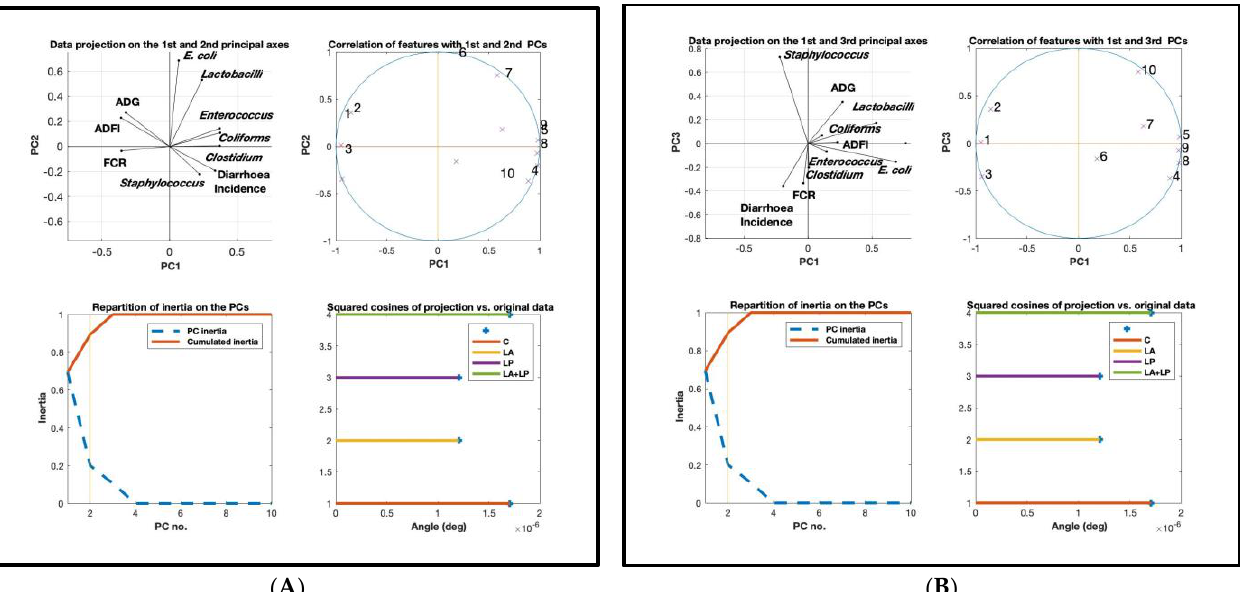
Figure 4. Results of the principal component analysis (PCA), where: ( A ) is the graphical representation of the first and second principal components (PC1 and PC2), covering 89% of the global variance, correlation of features with first 2 PCs, inertia and angle degree. ( B ) is the graphical representation of the first and third principal components (PC1 and PC3), covering 79% of the global variance, correlation of features with first and 3rd PCs, inertia and angle degree. ADG — average daily gain; ADFI — average daily feed intake; FCR — feed conversion ratio.